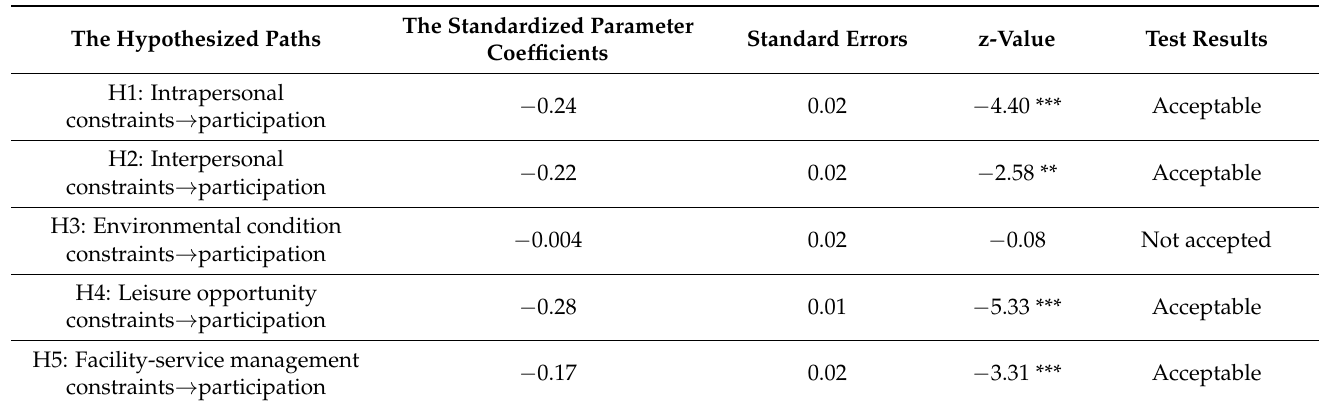
Table 6. Summary of the hypothesized SEM model ( n = 2901).